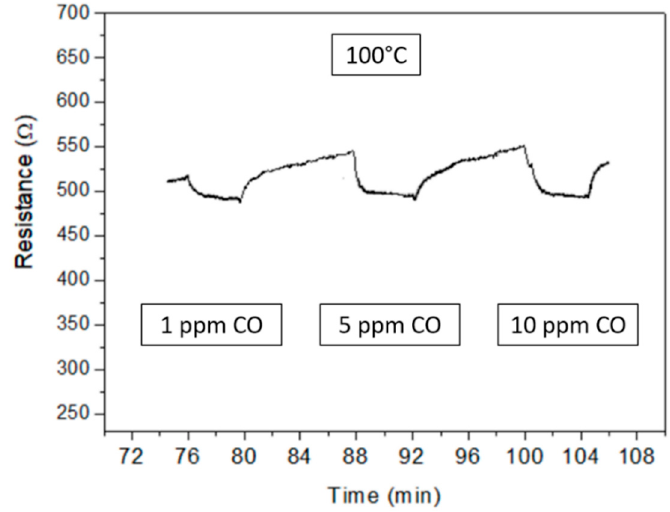
Figure 5. Transient sensor response at T = 100 °C and different CO concentrations.